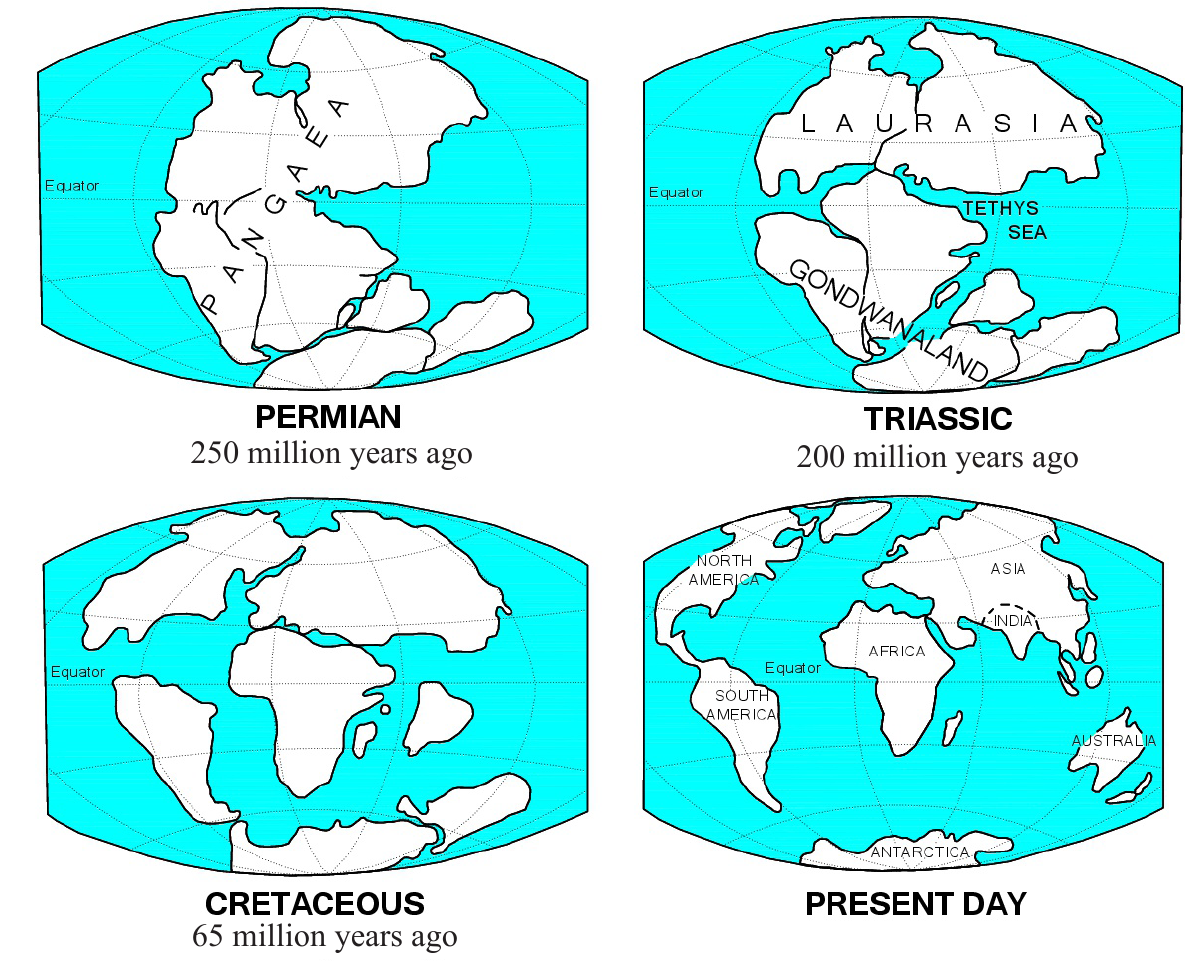
Figure 2: The geological history of India and Sri Lanka in relation to plate tectonics. Sri Lanka has always been connected to the Indian subcontinent that was part of Pangaea during the Permian period (250 to 300 Mya). Pangaea split apart at the end of the Triassic (200 Mya) into two supercontinents: Laurasia to the north and Gondwana drifting southward. Gondwana itself broke apart about 180 Mya ago into progressively more separated landmasses that we know today as South America, Africa, Antarctica, Australia, the Arabian Peninsula and India. For about 90 My India drifted rapidly northward as an isolated island in the Thethys Sea and crashed into Laurasia about 35 to 55 Mya to take up its present position. Fluctuating sea levels have repeatedly submerged or emerged the land bridge connecting India and Sri Lanka at the shallow Palk Strait during the Pleistocene (Modified from The Future Mapping Company,